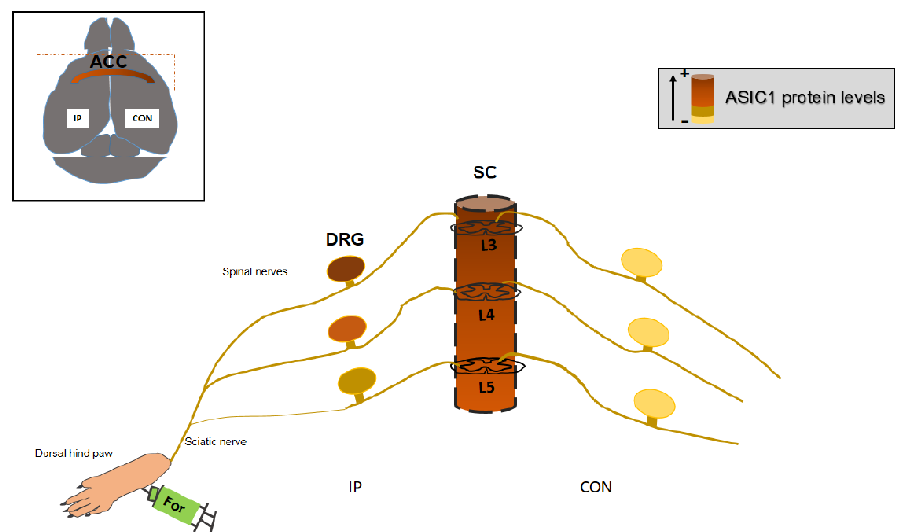
Figure 6. Schematic representation of ASIC1 upregulation in ACC, SC and DRG in the formalin mouse model of pain. At the cortex, the ACC contralateral to the injection (left hind paw) shows a higher ASIC1 protein level. At the SC and DRGs, there is a gradient decreasing from L3 to L5 lumbar segments. Spinal nerves contribution to the sciatic nerve is represented with lines, thicker for those contributing to a greater extent. ASIC1 protein levels are represented showing an increase with more intense color. (IP, ipsilateral; CON, contralateral; ACC, Anterior Cingulate Cortex; DRG (Dorsal Root Ganglia; SC, Spinal Cord; L3, 4, 5, lumbar 3, 4, 5).